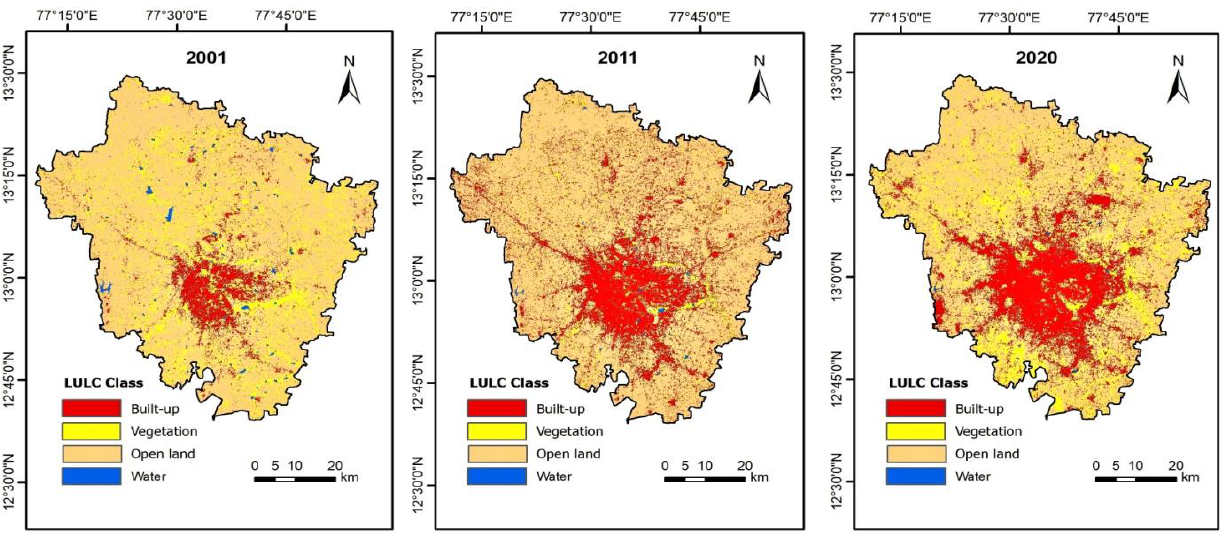
Figure 6. Spatio-temporal pattern of LST in Delhi.